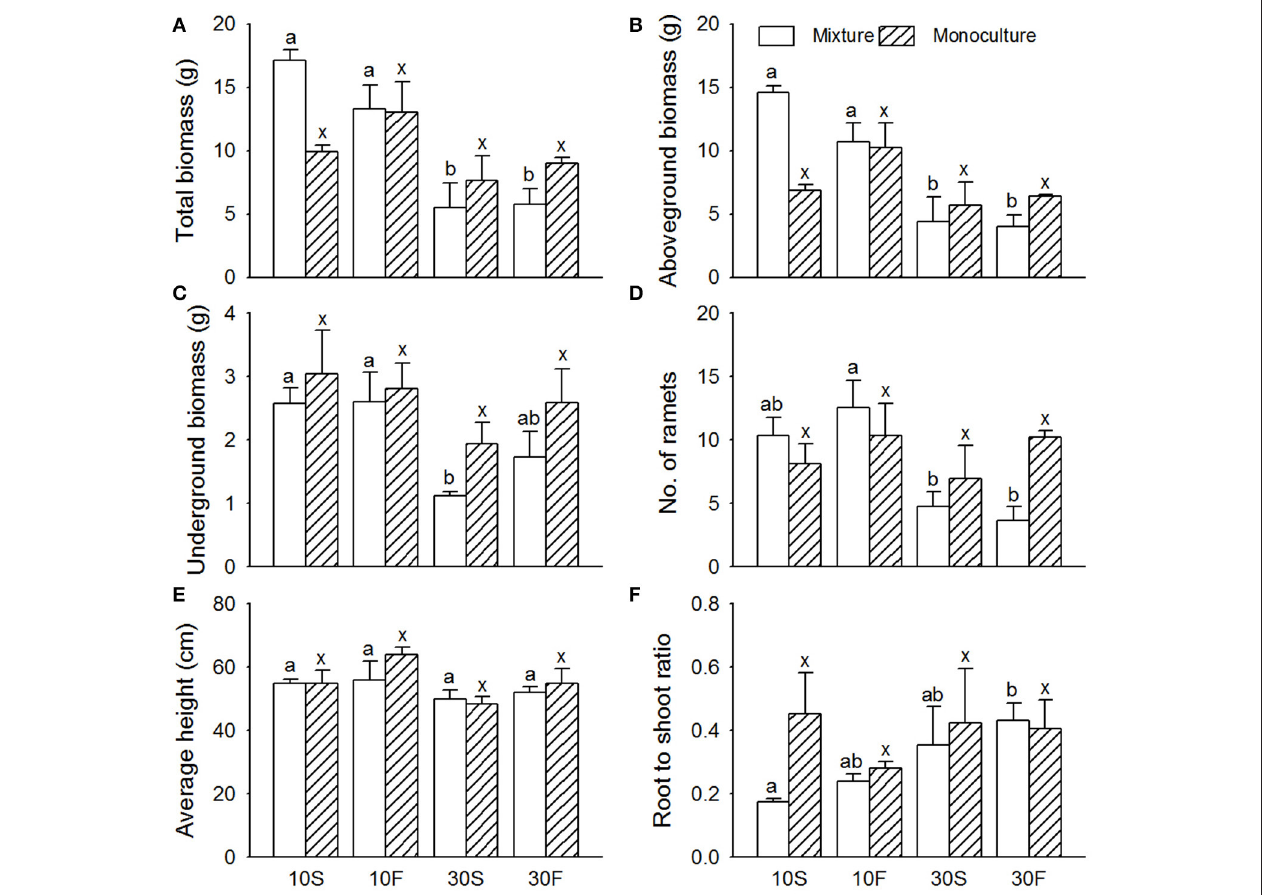
FIGURE 2 | Effects of interspecific interaction and hydrological conditions on the (A) total biomass, (B) aboveground biomass, (C) belowground biomass, (D) number of ramets, (E) average height, and (F) root-to-shoot ratio (mean + SE) of Scirpus planiculumis . Different letters indicate a significant difference among mixture or monoculture treatments (at P <